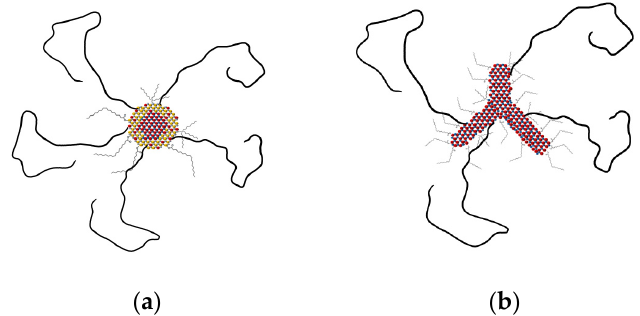
Figure 4. Schematic presentation of spherical core-shell CdSe/ZnS ( a ) and non-spherical CdSe ( b ) QDs chemically bound with macromolecules. ( b ) QDs chemically bound with macromolecules.